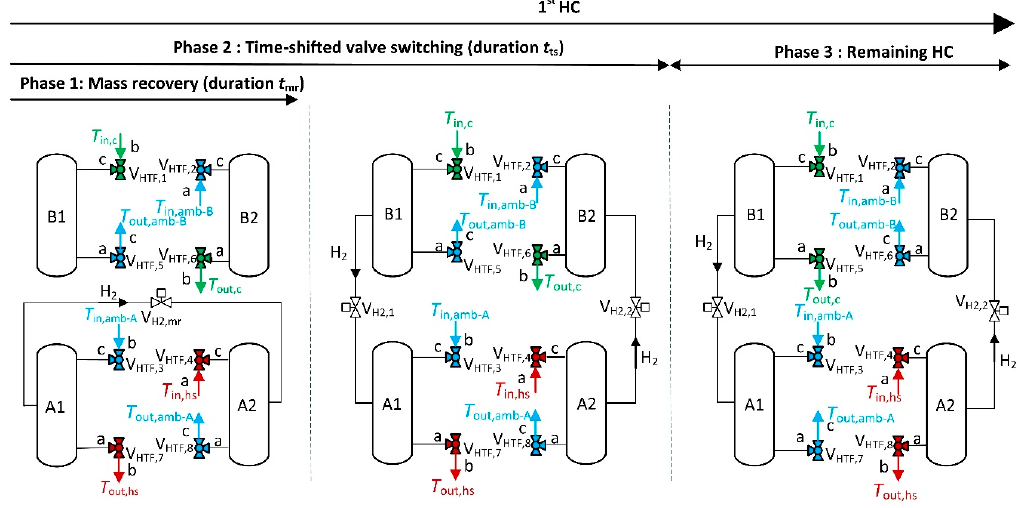
Figure 6. Illustration of the states of operation of the realized MHCS for the 1st HC.